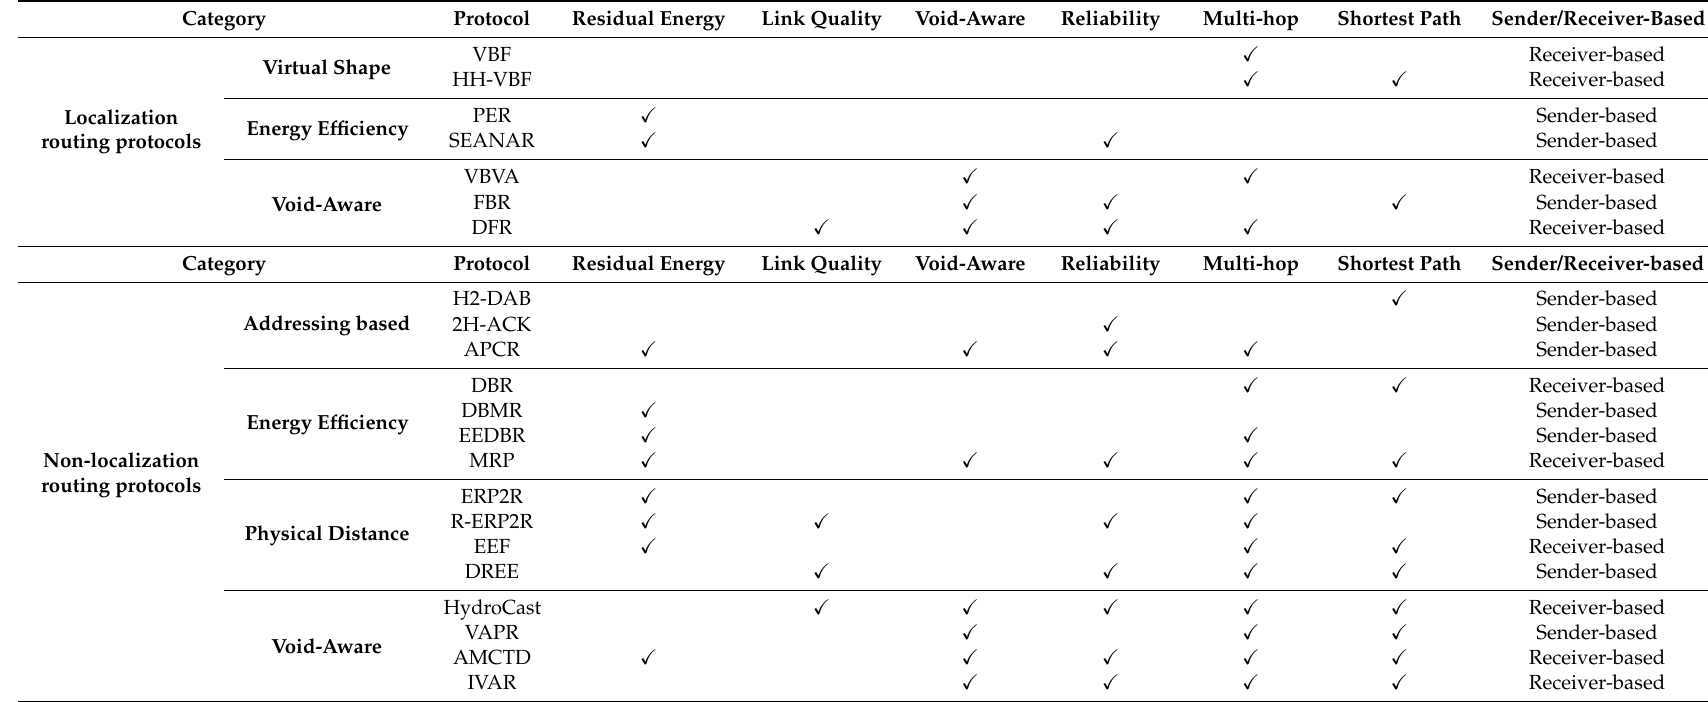
Table 2. Comparison of the main factors in routing protocols in